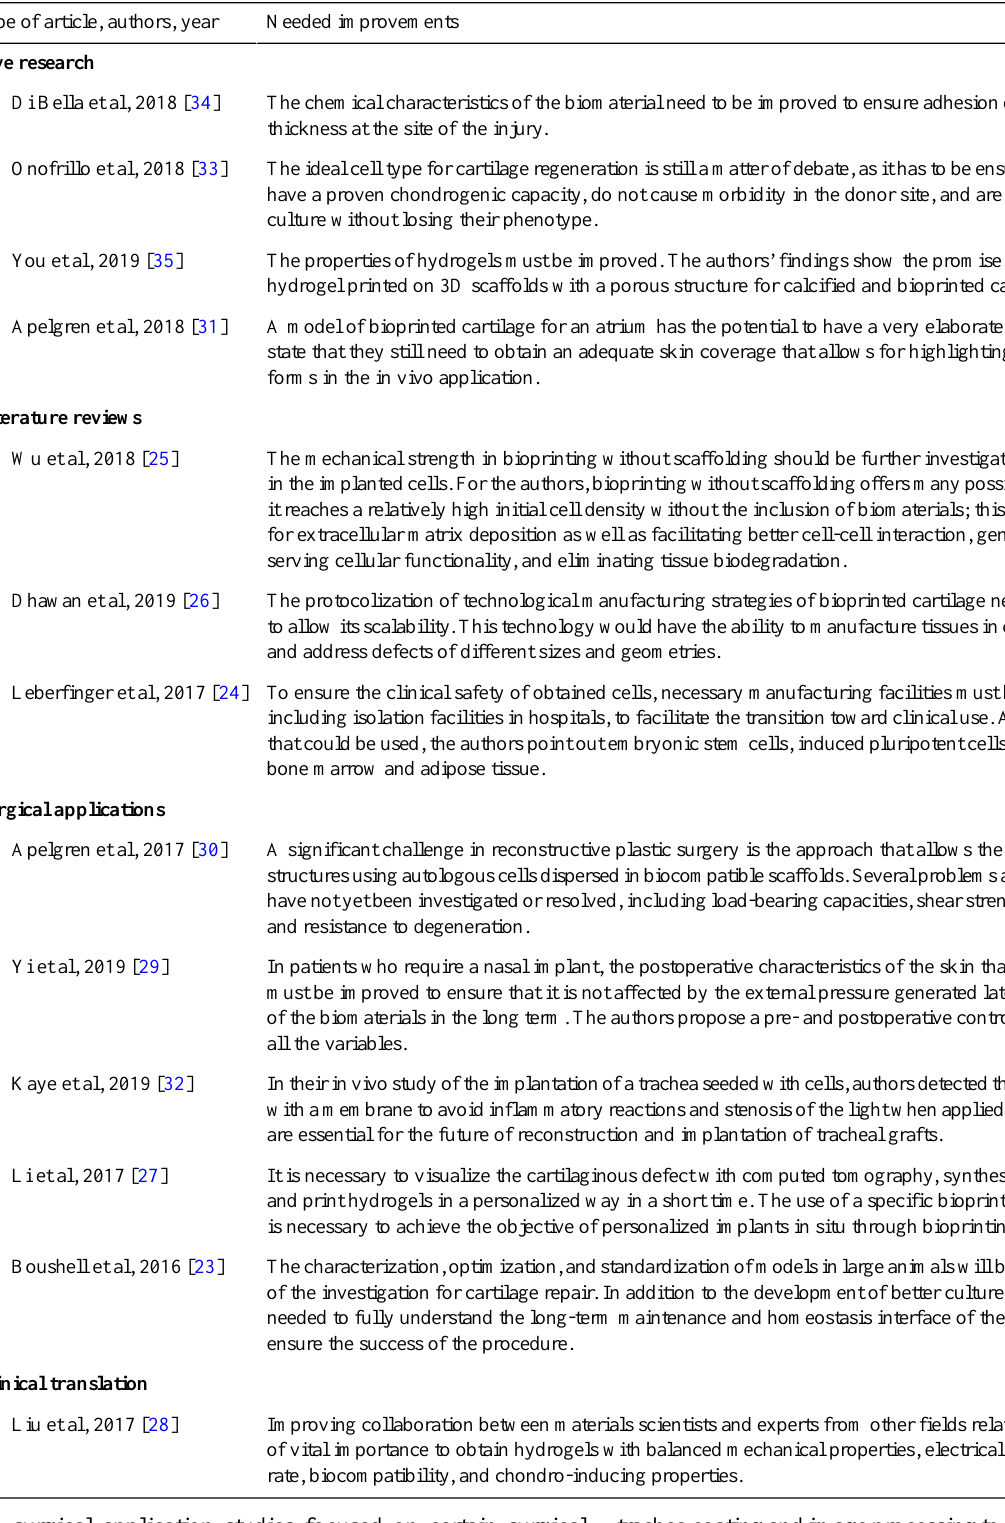
Table 4. Needed improvements in the technical